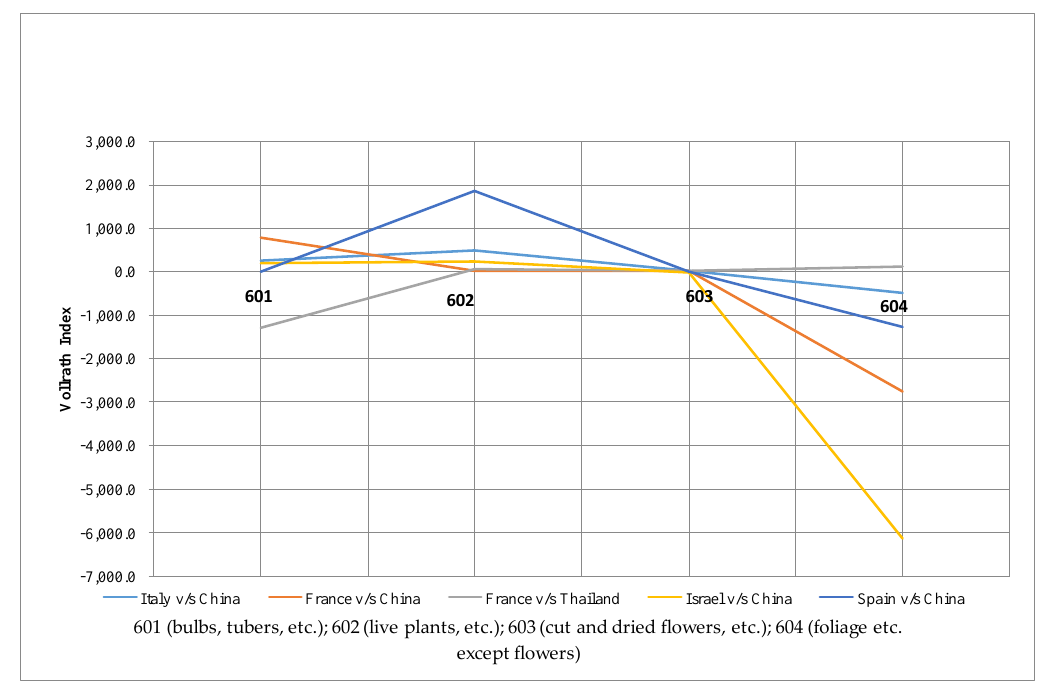
Figure 7. Trade between some countries of the Mediterranean Basin and some areas at risk (2018). Figure 7 indicates the Vollrath index of trade dependence in direct exchanges between countries of the Mediterranean Basin and some countries at risk where X. citri is present. Spain depends on China for bulbs and cuttings, cut flowers, and foliage (all with negative values). France shows behavior similar to Italy toward China, but less toward Thailand, upon which it depends for a consistent flow of imported bulbs and